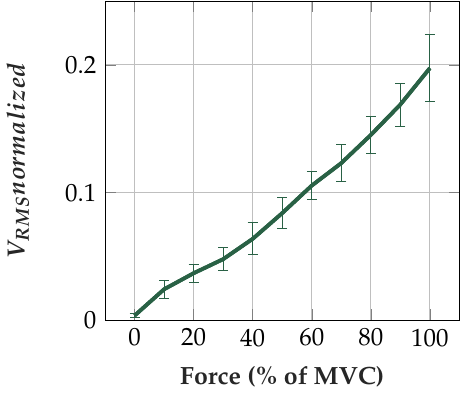
Figure 20. Normalized V RMS at different muscle force levels.